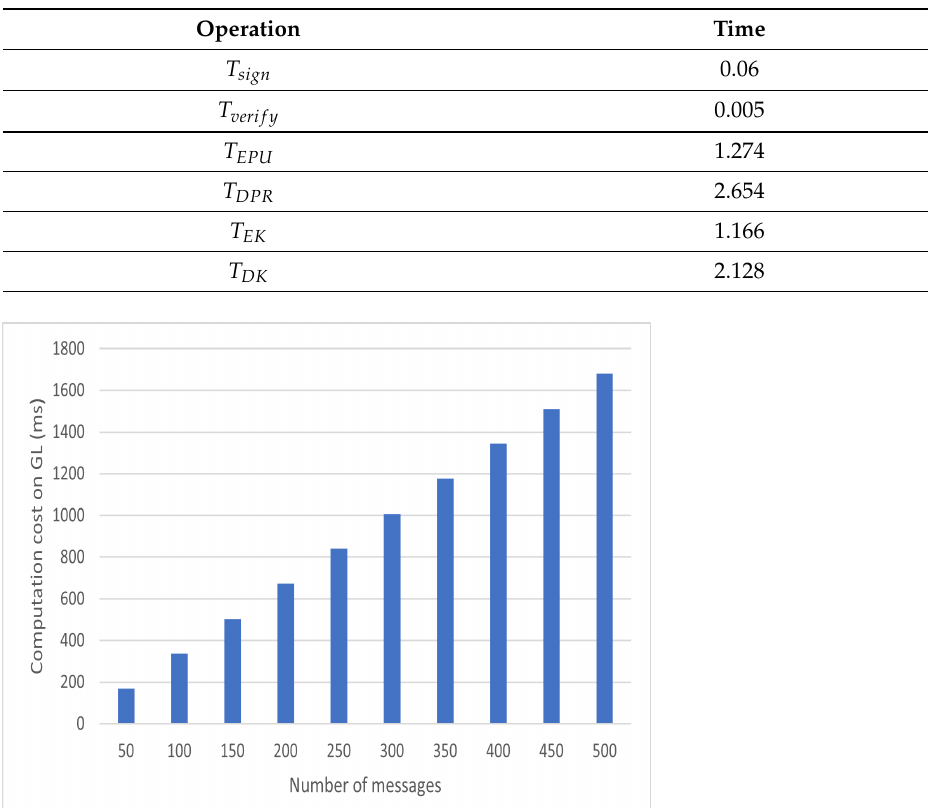
Table 2. Execution time for different operations (milliseconds).